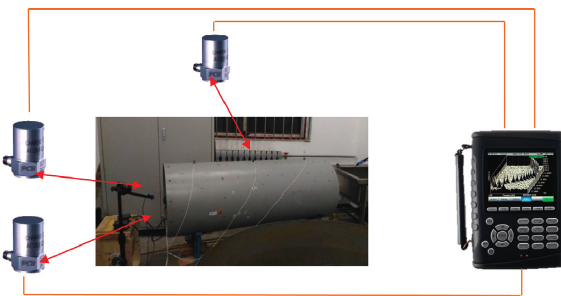
Figure 19: The setup of the experimental study.